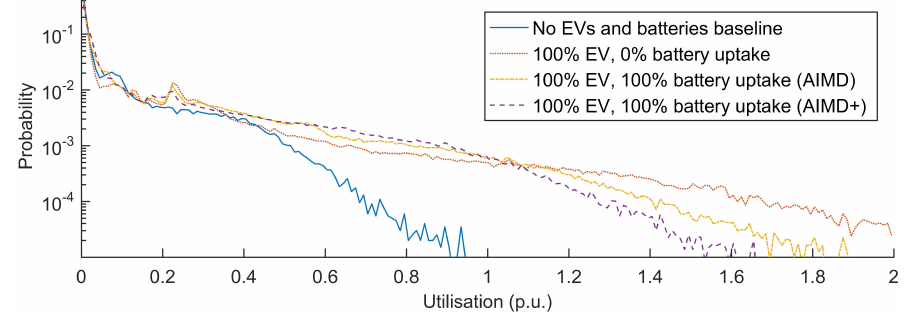
Figure 10. Line utilisation probability distribution of all lines in the simulated feeder for certain uptakes of EV and battery storage devices. Here, Case A is blue; Case B is red; Case C is yellow; and Case D is = − 0.360 and ζ ∗∗ = − violet; with ζ ∗∗ D C